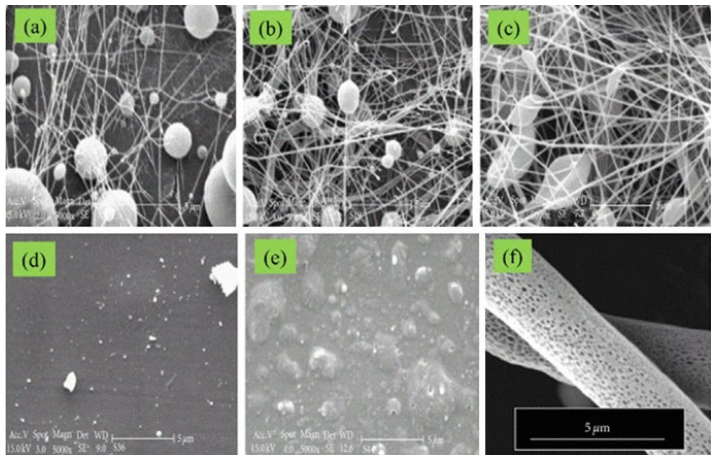
Figure 6. SEM images of 5% polycaprolactone solutions dissolved in various solvents: ( a ) glacial acetic acid, ( b ) 90% acetic acid, ( c ) methylene chloride/DMF = 4/1, ( d ) glacial formic acid, ( e ) and formic acid/acetone, along with ( f ) SEM images of polyvinyl butyral nanofibers prepared from 10 wt.% tetrahydrofuran/dimethyl sulfoxide (9/1 v / v ). Reproduced from reference [92] with permission